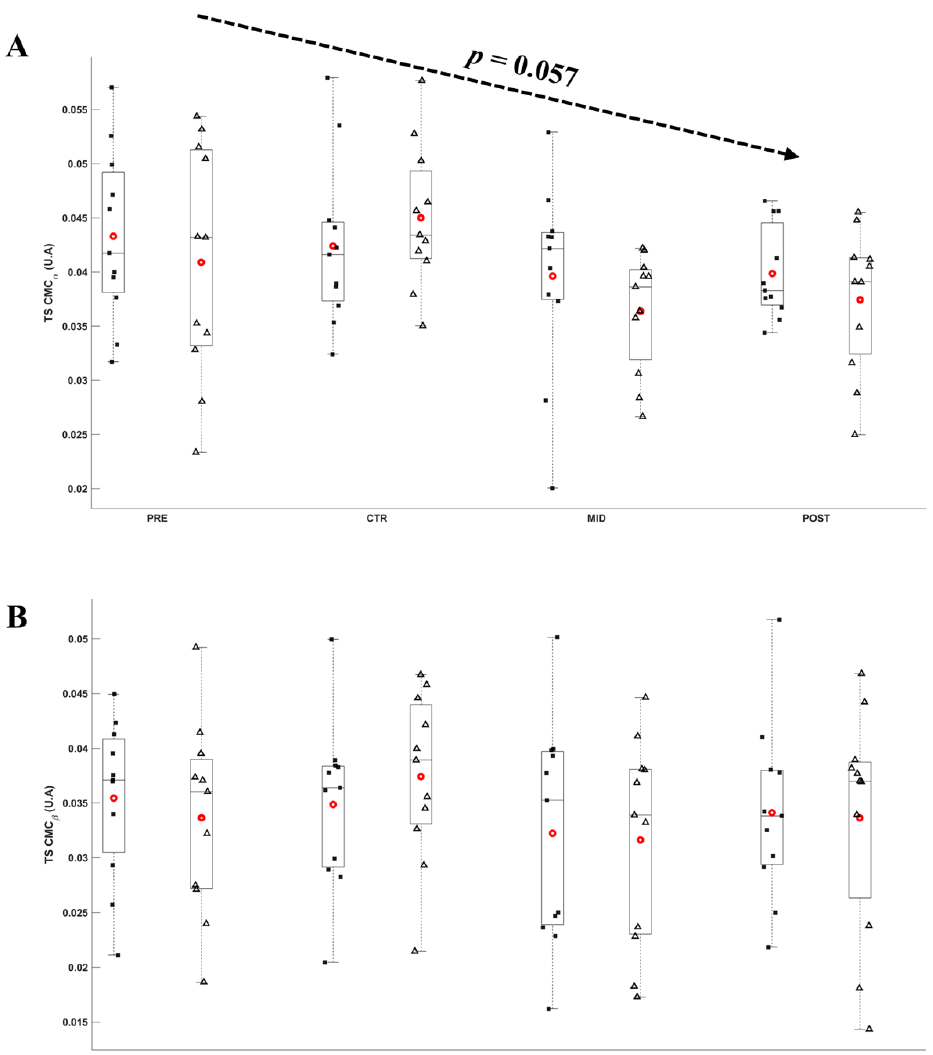
Figure 9. Average α ( A ) and ß ( B ) CMC TS during submaximal contractions computed according to the torque levels, T 0 (black square) and Ti (white triangle), and evaluation sessions (PRE, CTR, MID, POST sessions). Each whiskers box indicates the mean (red circle) and the median (horizontal line). The inferior and superior edges of the box indicate the 25th and 75th percentile, respectively. Black dots represent individual participant performance. Error bars represent the most extreme and non-outlier data points.